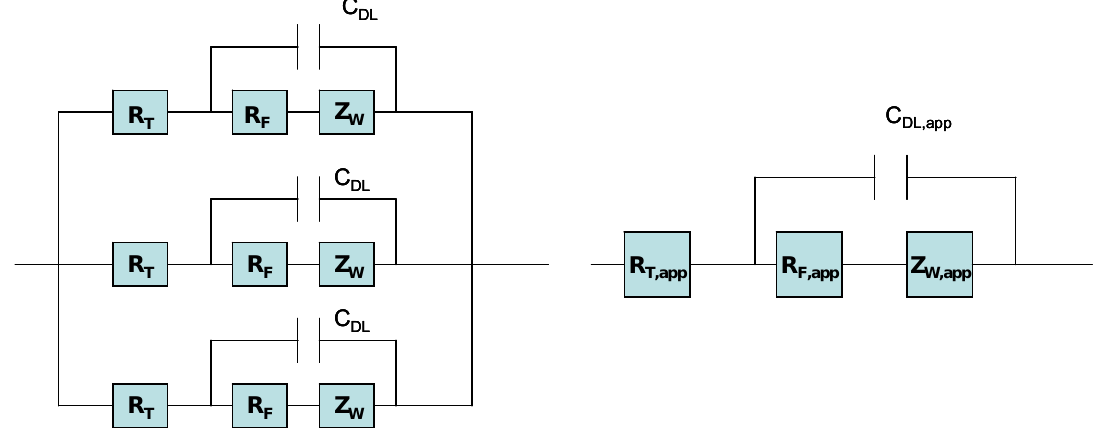
Figure 8. Electrical equivalent circuit of ensemble of randomly dispersed SWCNT on metal support